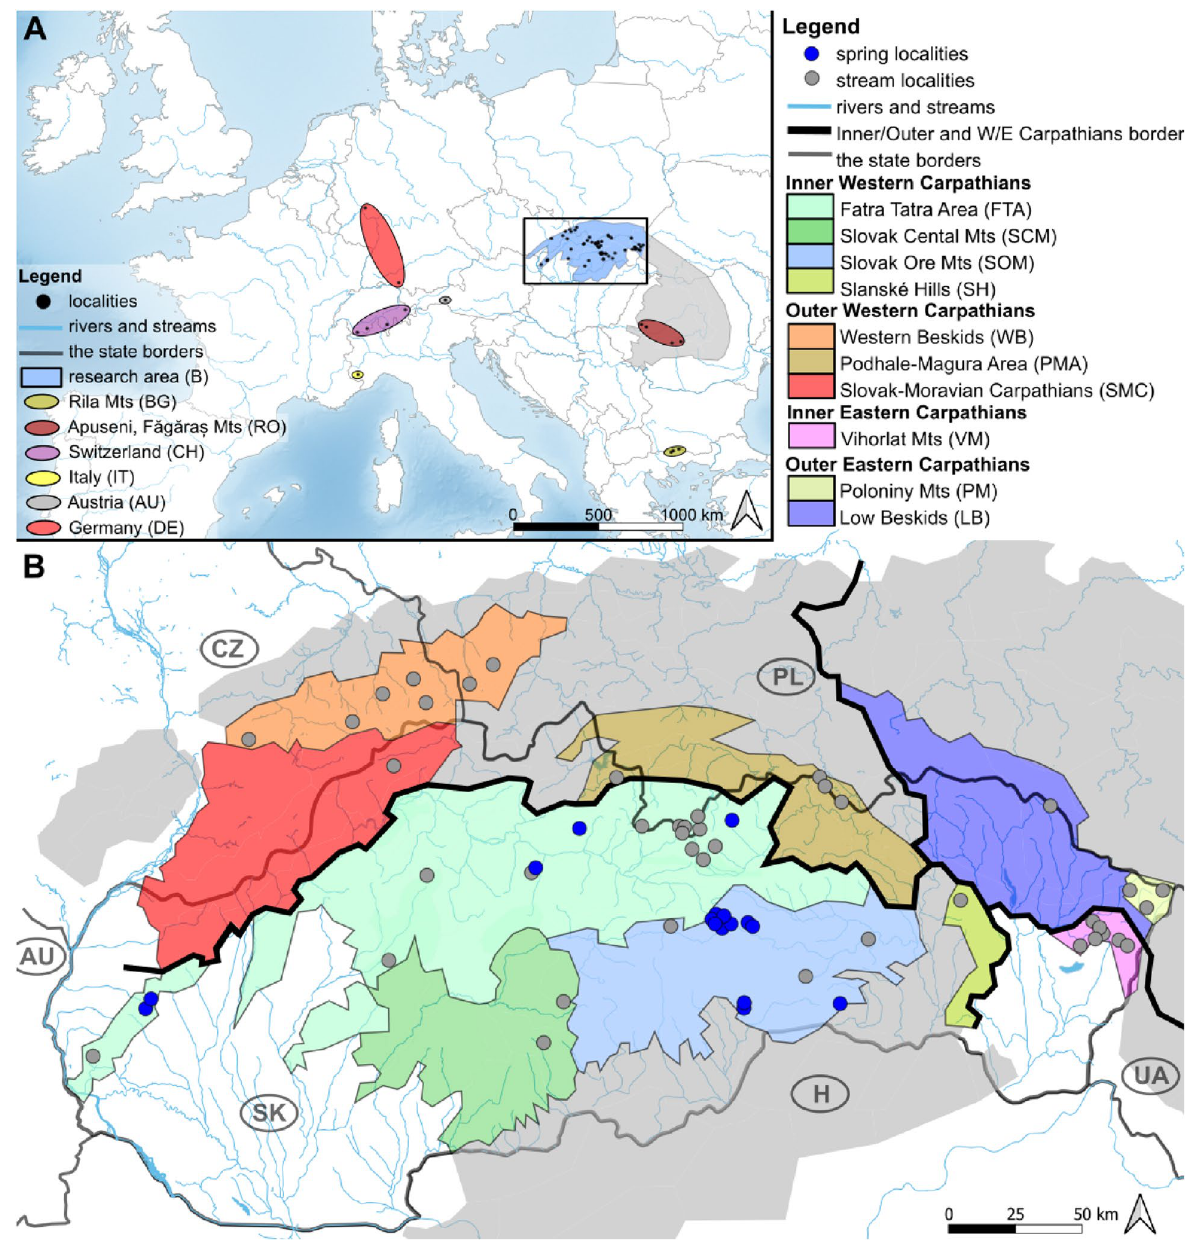
Figure 1. Distribution of the R. tristis sites. ( A ) Map of the research area (rectangle) within Europe and 15 localities from outside of the research area (ellipses); ( B ) Research area with 58 sampling sites (15 springs, 43 streams) divided into ten physiographic units represented by different fill colours (see legend). Abbreviations: Slovakia (SK), Hungary (H), Ukraine (UA), Poland (PL), Czech Republic (CZ), Austria (AU), Bulgaria (BG), Romania (RO). Map created with QGIS 3.16 (https:// qgis.